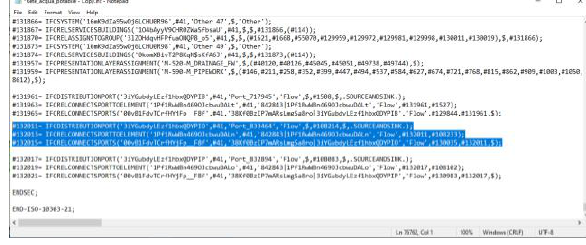
Figure 5a. IFC code editing for topological relations enrichment